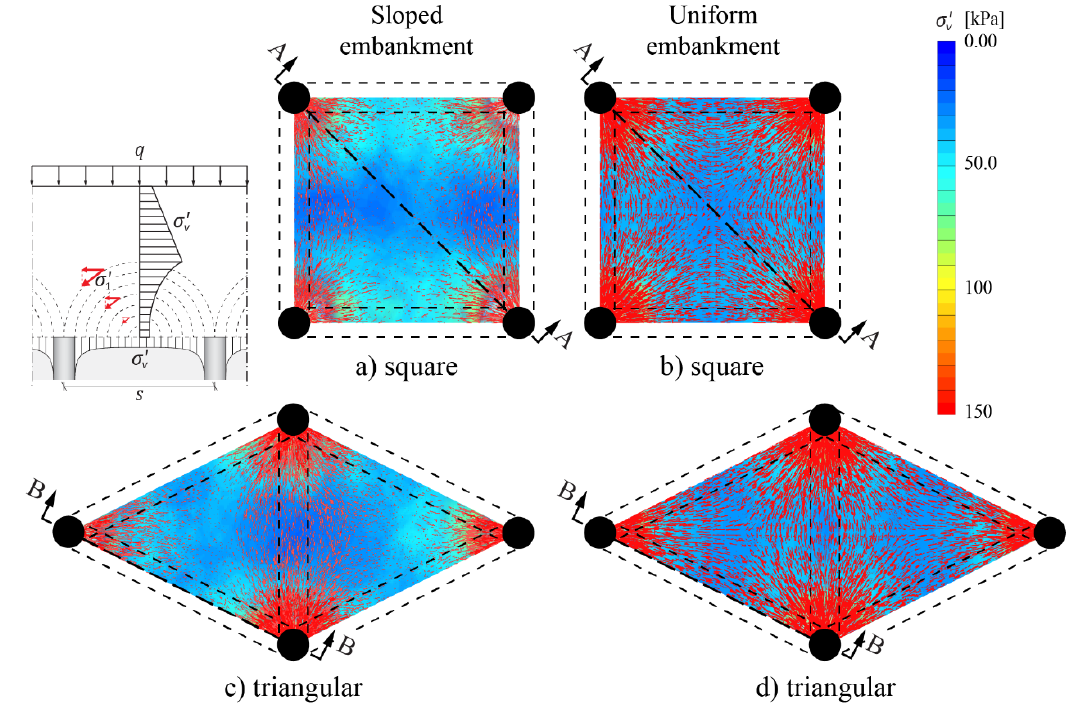
Figure 12. Detailed view of the areas marked with dashed lines in Figure 11, showing the distribution of 𝜎 𝘷(cid:4593) and 𝜎 (cid:2869)(cid:4593) -vectors, projected on a horizontal plane, as red lines for a pile group with square ( a , b ) and triangular ( c , d ) pile arrangements, with 𝑠 = 1.4 m for a sloped embankment ( a , c ) and an embankment with a uniform height of 2.50 m ( b , d ).